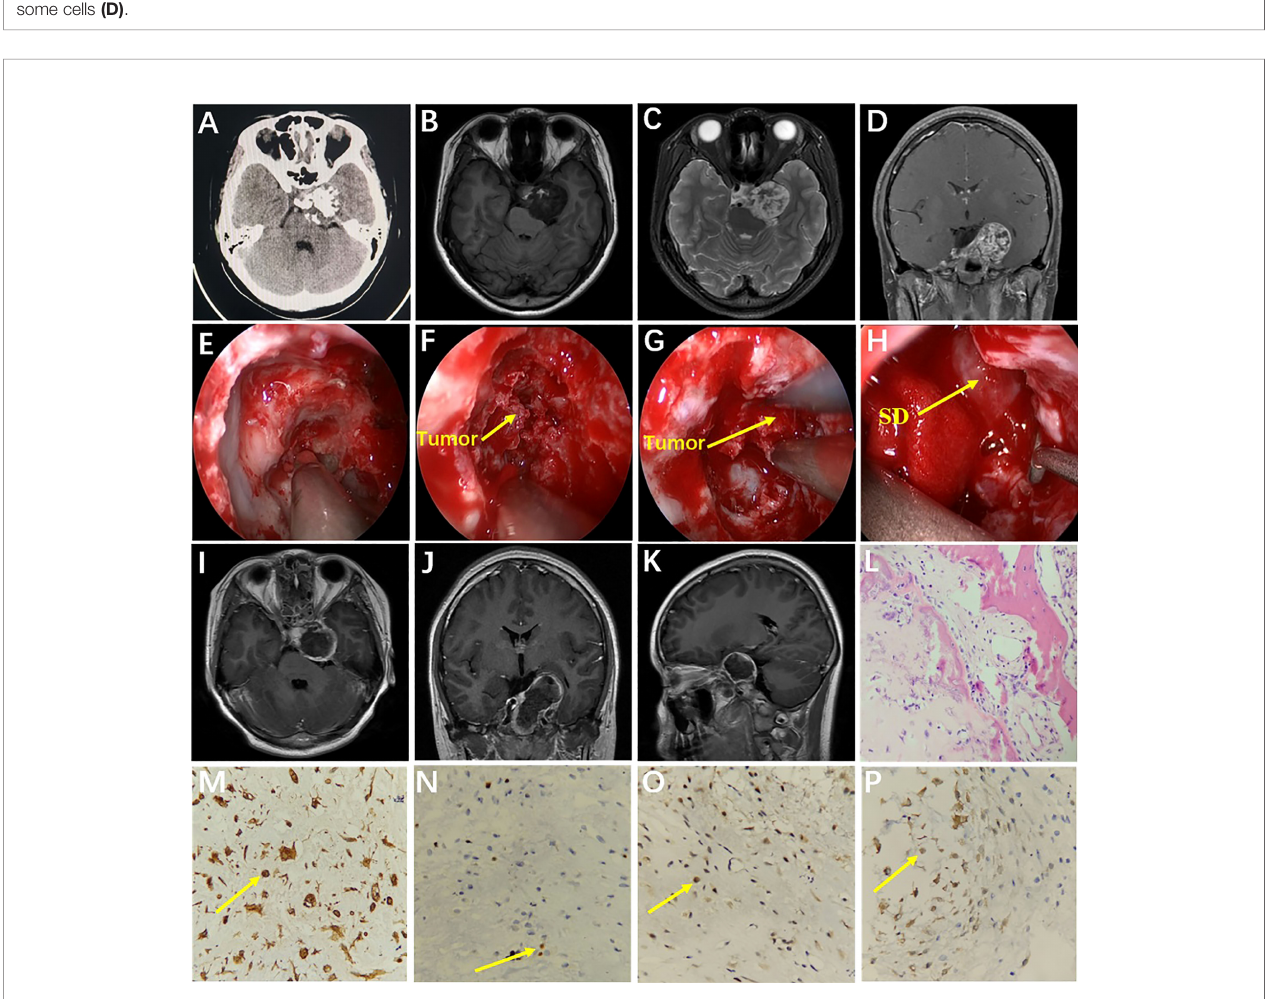
FIGURE 3 | Preoperative CT showed medium-high mixed density in the sella (A) . Preoperative MRI showed long T1 (B) and long T2 (C) signals in the left parasella. Multiple patchy short T2 signals were seen in the lesion (C) . After enhancement, the lesion showed heterogeneous enhancement (D) . Intraoperative drilling of anterior wall of sphenoid sinus and sella fl oor by EEETA (E) . Resection of tumor located in sella turcica (F) . Resection of tumor in the left parasella (G) . Descent of sellar diaphragm after removal of tumor (H) . Postoperative axial, coronal, and sagittal MRI enhancement showed that the tumor was completely removed and there was no residual tumor in surgical area (I – K) . Histopathological examination (hematoxylin and eosin [H&E] staining) at 200× magni fi cation showed tumors in the myxoid matrix background consisting of hyaline chondrocytes with irregular lobules, spindle cells, and chondrocytes with homogeneous micronuclei (L) . Immunohistochemical staining at 400× magni fi cation showed vimentin (+, M ), Ki-67 (6%, N ), SOX-9 (+, O ), and S-100 (+, P ). EEETA, extended endoscopic endonasal transsphenoidal approach; SD, sellar diaphragm.